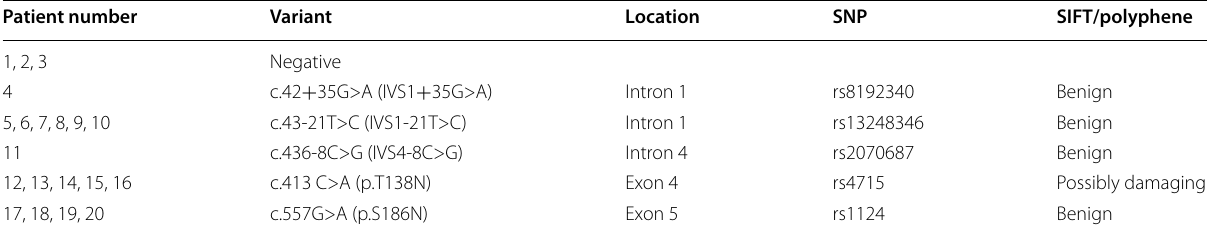
Table 2 Variants identified in SFTPC